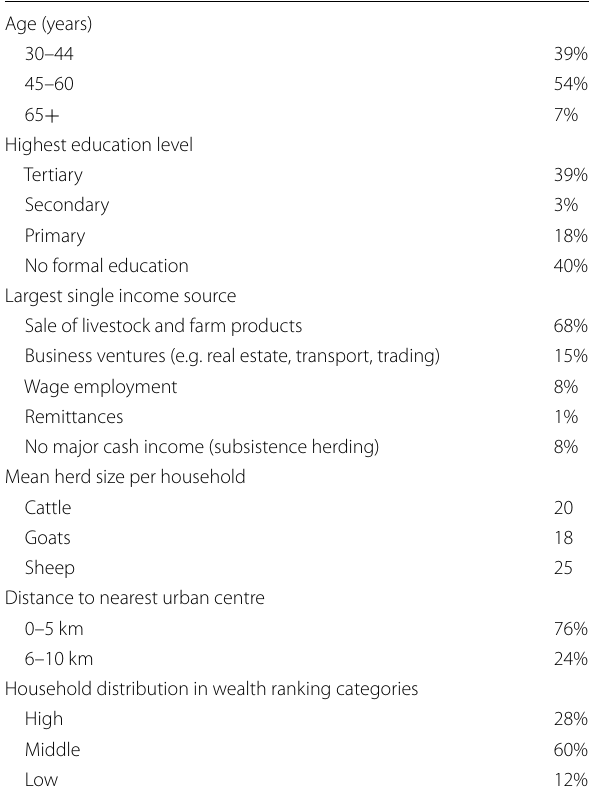
Table 1 Selected attributes of household survey participants (